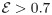
Collective decisions on a fully-connected network: comparison between the micro and the macro dynamics and scaling properties.(A,C) Comparison between the stochastic finite-size macroscopic model (black lines) and the multiagent implementation with both the homogeneous strategy (red lines) and the heterogenous strategy (green lines). Results are displayed for varying system size N. For each possible configuration (v
A, v
B), 500 independent runs are performed. We show results for configurations with effectivity E>0.7. The plot is divided in two parts: in the bottom-right triangle, we consider the success rate S for each configuration (v
A, v
B), where v
A ≥ v
B. For each group size N, we show the isolines at S=0.9. The gray triangle indicates quality value pairs below the target resolution R = 0.15 (i.e., configurations in which the two options are considered equivalent). In the top-left half of the plot, we consider the convergence time C for each configuration (v
A, v
B), where v
B ≥ v
A (i.e., the symmetric problems with respect to the bottom-right plot). For each group size N, we show the isolines at C=C^. (B, D) Scaling of the convergence time C with the system size N. For each configuration (v
A, v
B), we fit the curve C=bNa and we show the heat-map for the fitted coefficient a (see the bottom-right triangle showing the coefficient value for each configuration (v
A, v
B), v
A ≥ v
B) and b (see the top-left triangle showing the coefficient value for symmetric configurations (v
A, v
B), v
B ≥ v
A) across the decision space. Also in this case we show only configurations where E>0.7 for all N, and the white space indicates configurations with low effectivity. (A,B) Results for case-study 1A with v
i ∈ [0, 1], γ
i = 0.6v
i, α
i = 0, ρ
i = 0.1v
i, σ
i = 1 and i ∈ {A, B}, C^=50s. (C,D) Results for case-study 1B with v
i ∈ [1, 10], γ
i = ρ
i = v
i, α
i = 1/v
i, σ
i = 10 and i ∈ {A, B}, C^=1s.